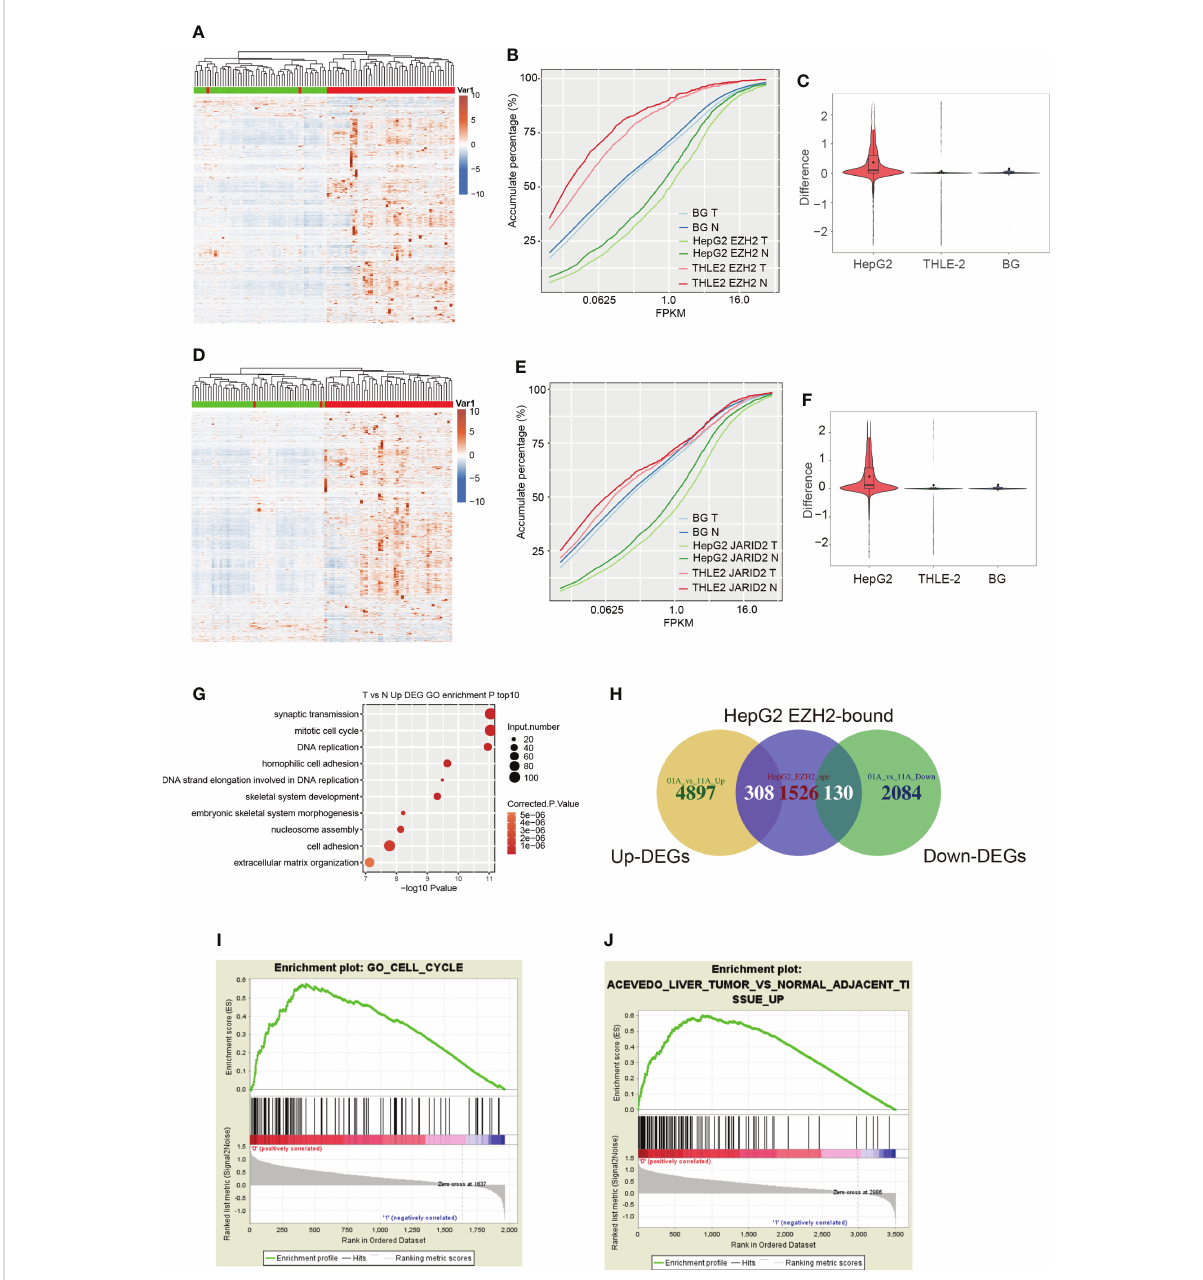
FIGURE 2 The expression pattern and functional analysis of EZH2 bound transcripts in HepG2 cells. (A) Hierarchical clustering heatmap showing the expression pattern of genes speci fi cally bound by EZH2 in HepG2 cells compared with THLE-2 cells. The expression levels of genes were obtained from the TCGA database. The samples with the green bar were adjacent normal samples, and the samples with the red bar were HCC tumor samples. (B) Accumulative plot showing the expression pattern of speci fi cally EZH2-bound genes in HepG2 or THLE-2 cells, as well as all the expressed genes. (C) Violin plot showing the difference value between tumor and normal samples for speci fi cally EZH2-bound genes in HepG2 or THLE-2 cells, as well as all the expressed genes. (D – F) The three fi gures showing the similar results presented in (A – C) but for the bound genes by JARID2. (G) Bubble plot showing the top ten enriched biological processes for genes upregulated in HCC compared with adjacent normal samples. (H) Venn diagram showing the overlapped genes between EZH2 binding and DEGs from the TCGA database. (I) GSEA analysis results showing the enriched gene set for genes speci fi cally bound by EZH2 in HepG2 cells compared with THLE-2 cells. (J) GSEA analysis results showing the enriched gene set for genes speci fi cally bound by JARID2 in HepG2 cells compared with THLE-2